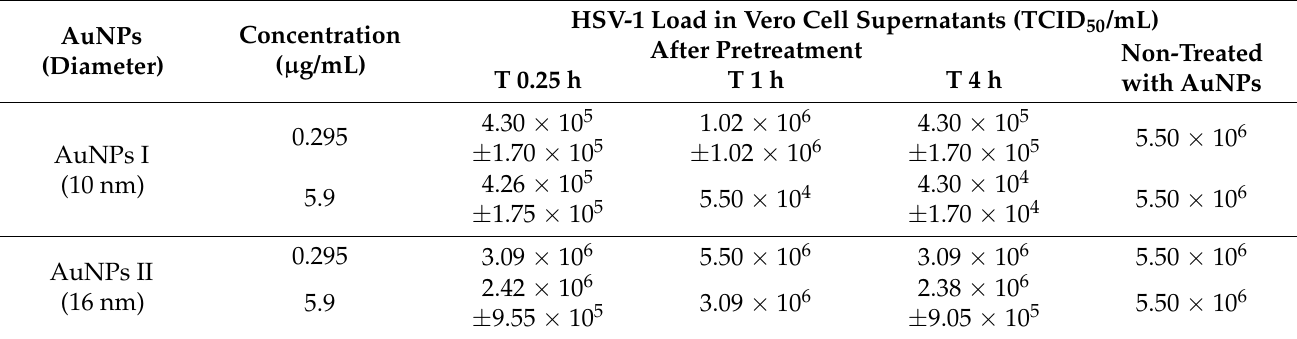
Table 1. Pretreatment assay. Vero monolayers were treated AuNPs infected with HSV-1 at different times, and supernatants were titrated on virus